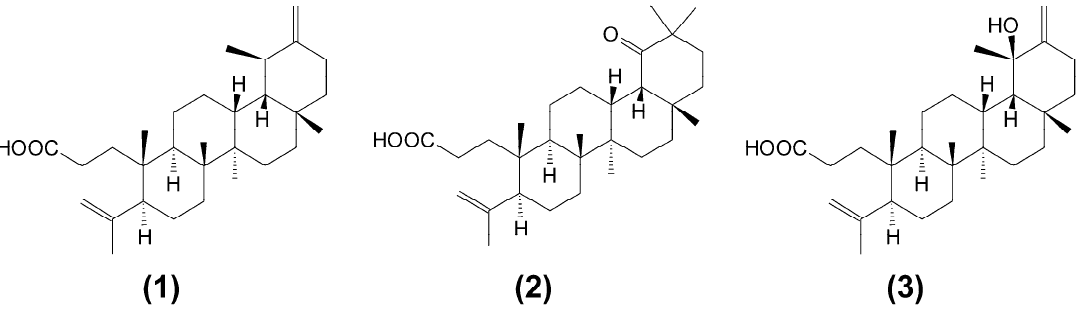
Figure 1. Chemical structure of triterpene seco -acids: 3,4- seco -urs-4(23),20(30)-dien-3-oic acid ( 1 ), 3,4- seco -olean-4(24)-en-19-oxo-3-oic acid ( 2 ), and 3,4- seco -urs-4(23),20(30)-dien-19-ol-3-oic acid ( 3 ).